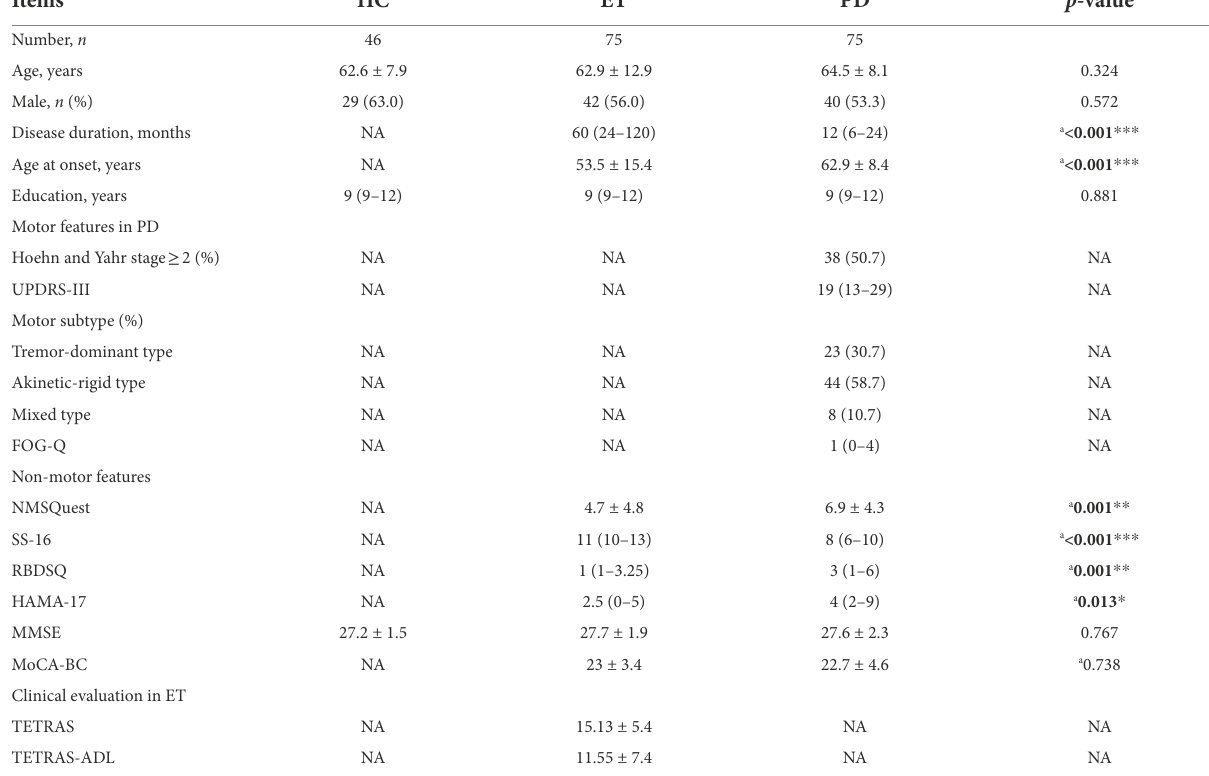
TABLE 1 Demographic and clinical features of de novo PD and ET